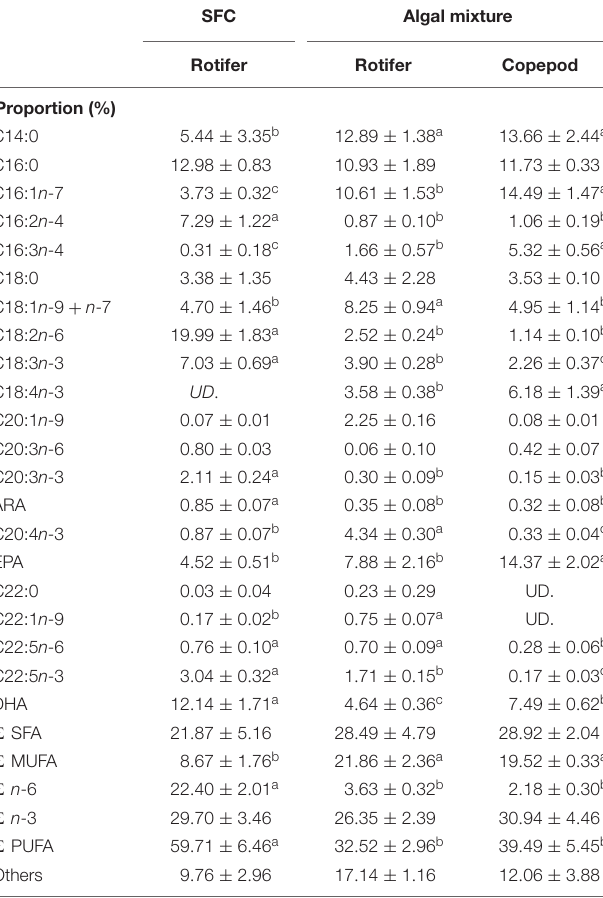
TABLE 2 | Fatty acid composition in total lipids of preys enriched with docosahexaenoic acid-supplemented Super fresh chlorella (SFC), or algal mixture. SFC Algal mixture Rotifer Rotifer